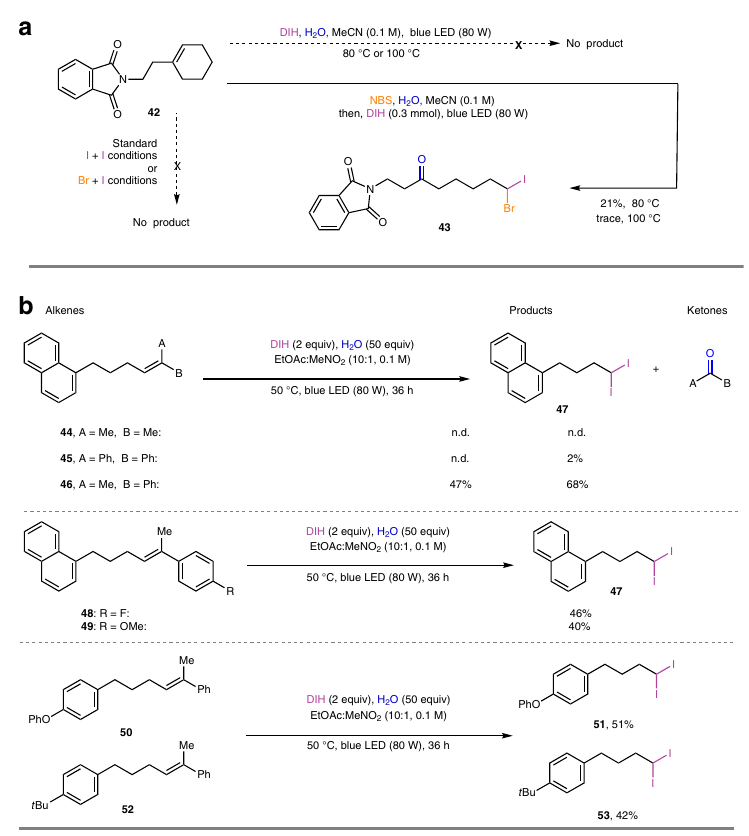
Fig. 4 Investigation of other trisubstituted alkenes. a Trialkyl-substituted cyclohexenes. b Acyclic trisubstituted